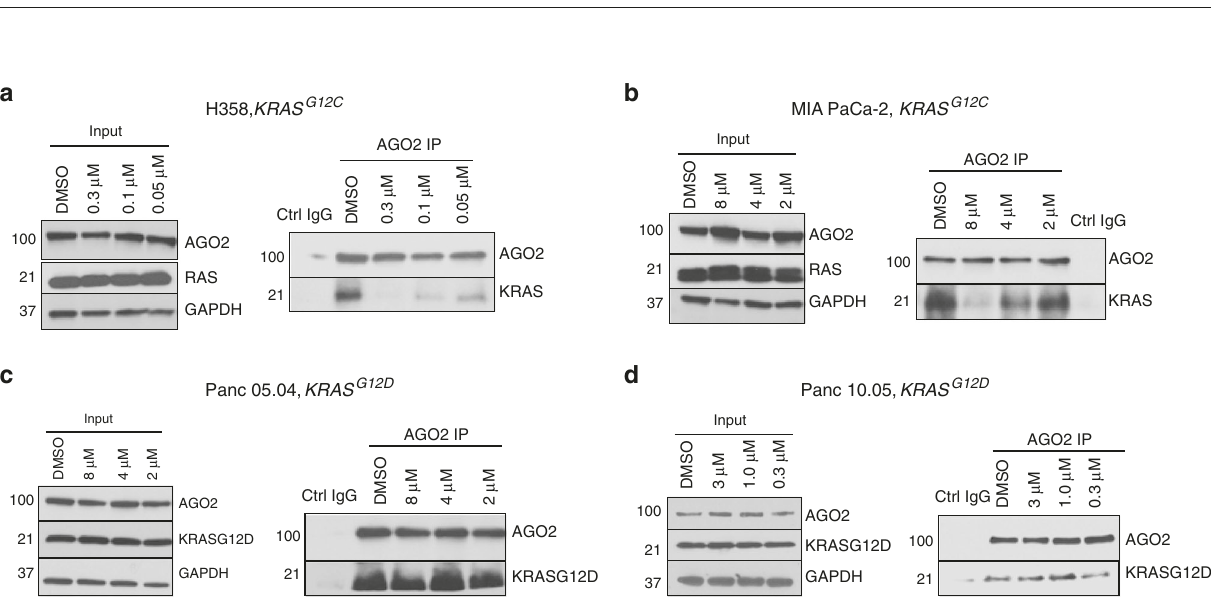
Fig. 7 Phosphorylation of AGO2 Y393 disrupts its interaction with KRAS. a Immunoprecipitation (IP) of endogenous AGO2 upon EGF stimulation (5 ′ ) in the indicated cancer cells expressing wild-type RAS followed by immunoblot analysis of KRAS. For MCF7 cells, endogenous co-IP analysis was performed using both AGO2 and KRAS-speci fi c antibodies. For each cell line and panel in this fi gure, MAPK activation and levels of various proteins are shown as input blots. b IP of endogenous AGO2 upon EGF stimulation (5 ′ ), in the indicated cancer cells harboring different KRAS mutations, followed by immunoblot analysis of KRAS. c Co-IP and immunoblot analysis of RAS and AGO2 upon EGF stimulation of HEK293 (wild-type KRAS ) cells expressing FLAG-AGO2 or ( d ) DLD-1 ( KRAS G13D ) cells in the presence or absence of erlotinib. e EGF stimulation and RAS co-IP analysis in HEK293 (wild-type KRAS ) and f MIA PaCa- 2 ( KRAS G12C ) cells expressing FLAG-tagged AGO2 (wild-type or Y393F). IP of endogenous AGO2 upon H 2 O 2 treatment (4 ′ ), in H358 ( g ) and MIA PaCa-2 ( h ) cells harboring KRAS mutations, followed by immunoblot analysis of KRAS. i H 2 O 2 treatment and KRAS-AGO2 co-IP analysis in MIA PaCa-2 ( KRAS G12C ) cells expressing FLAG-tagged AGO2 (wild-type or Y393F). Numbers on the left of the immunoblots in this panel indicate protein molecular weights in kDa. j Left panels, Representative images of single target (RAS or AGO2) and RAS-AGO2 interaction PLA in wild-type RAS expressing PC3 cells across the indicated cell culture conditions. Right panels, Representative images of PLA to detect RAS-AGO2 interaction in wild-type RAS expressing MCF- 7 (panel I) and oncogenic KRAS expressing HCT116 (panel II) and H358 (panel III) cells grown in the indicated culture conditions. PLA signals appear as red dots around DAPI stained nuclei in blue. Scale bar, 50 µ m.